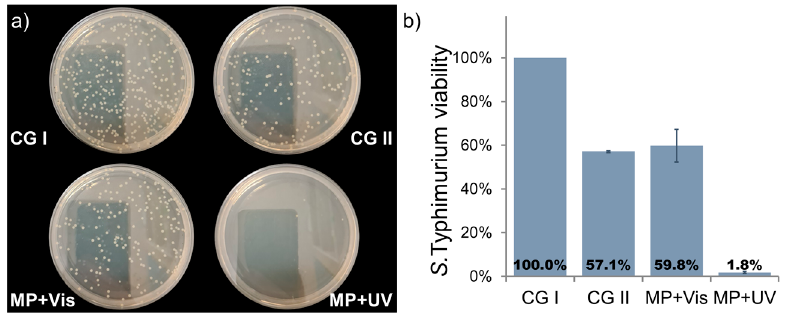
Figure 9. Results of S. Typhimurium bacteria plating and cultivation on agar plates after they were treated with ZnO+Ni MP powder under visible (MP+Vis) and UV (MP+UV) light irradiation: (a) qualitative representation and (b) averaged quantitative estimation. Two S. Typhimurium control groups (CG I without MP and CG II with MP) were maintained in the dark to determine the base values of bacteria viability.